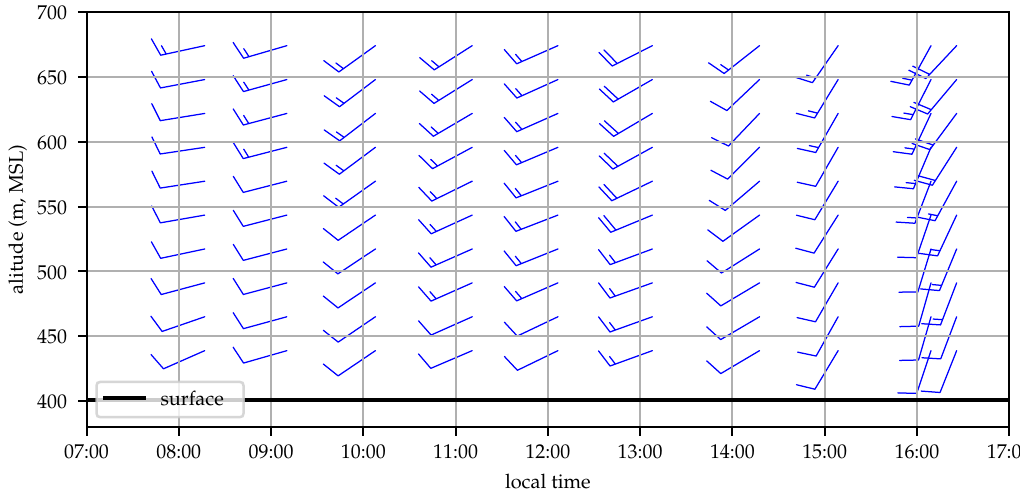
Figure 13. Time-altitude depiction of the profile of aircraft-estimated horizontal wind depicting its evolution throughout the day